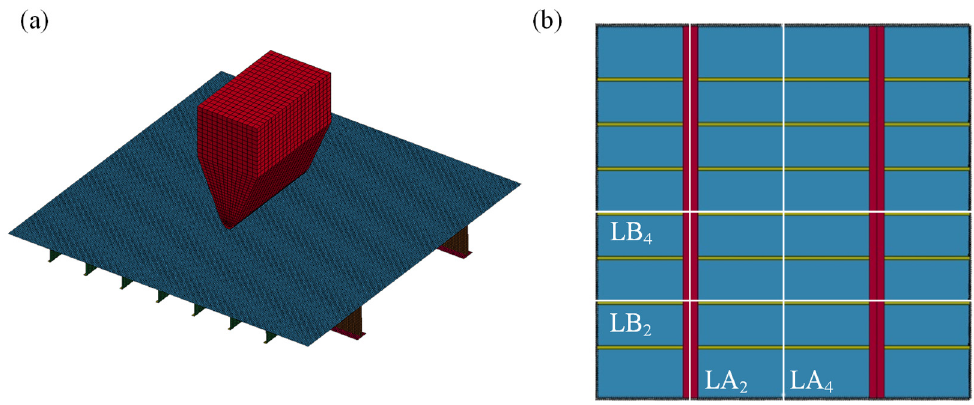
Figure 20. The finite element model of the impact test: ( a ) Whole model; ( b ) Stiffened panel and boundary conditions.